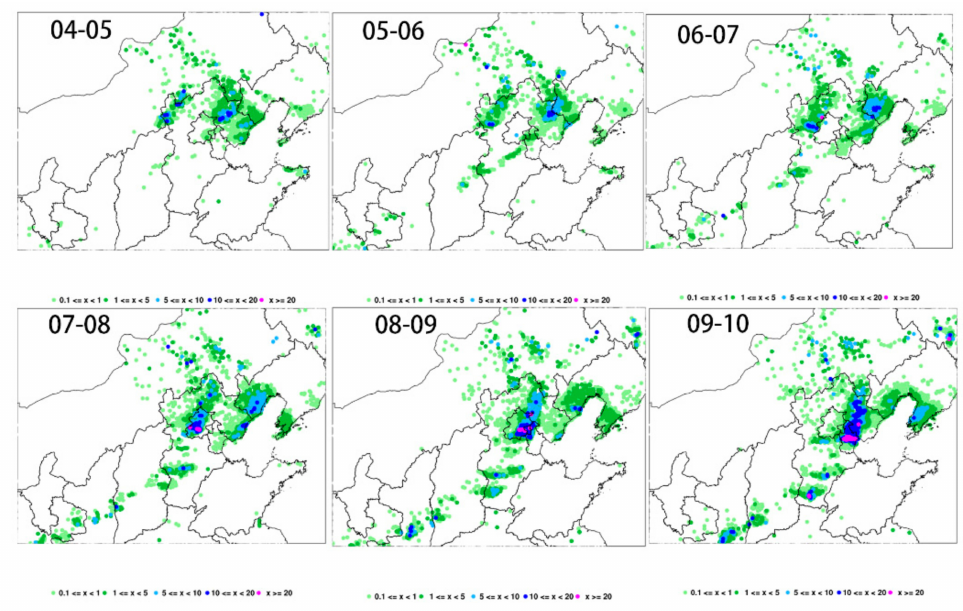
Figure 2. The evolution of hourly accumulated precipitation from AWS observation from 0500 UTC to 1000 UTC on 21 May 2020 in North